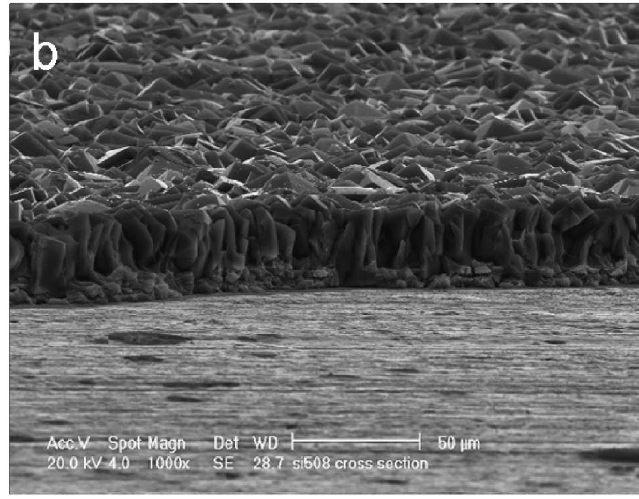
Figure 7. Cross-section view of an as-synthesized ZSM-5 zeolite coating on Al-2024-T3. The cross-sectional sample was prepared by etching away part of the film with hydrofluoric acid [29]. Reprinted with permission from Electrochemical Society, Inc.